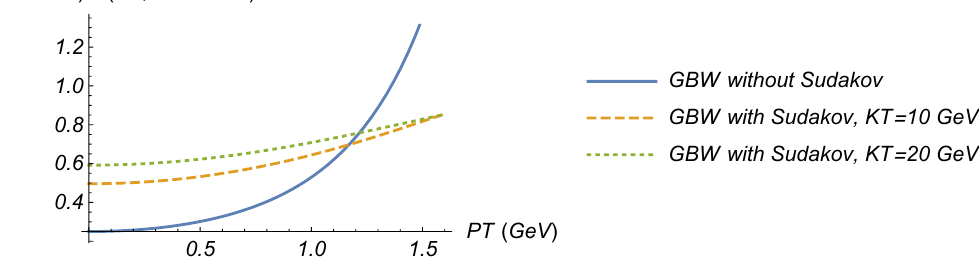
Figure 3 . Ratios of eq. (5.1) (solid blue line), eq. (5.2) with and eq. (5.2) with with Q s = 1 GeV, versus